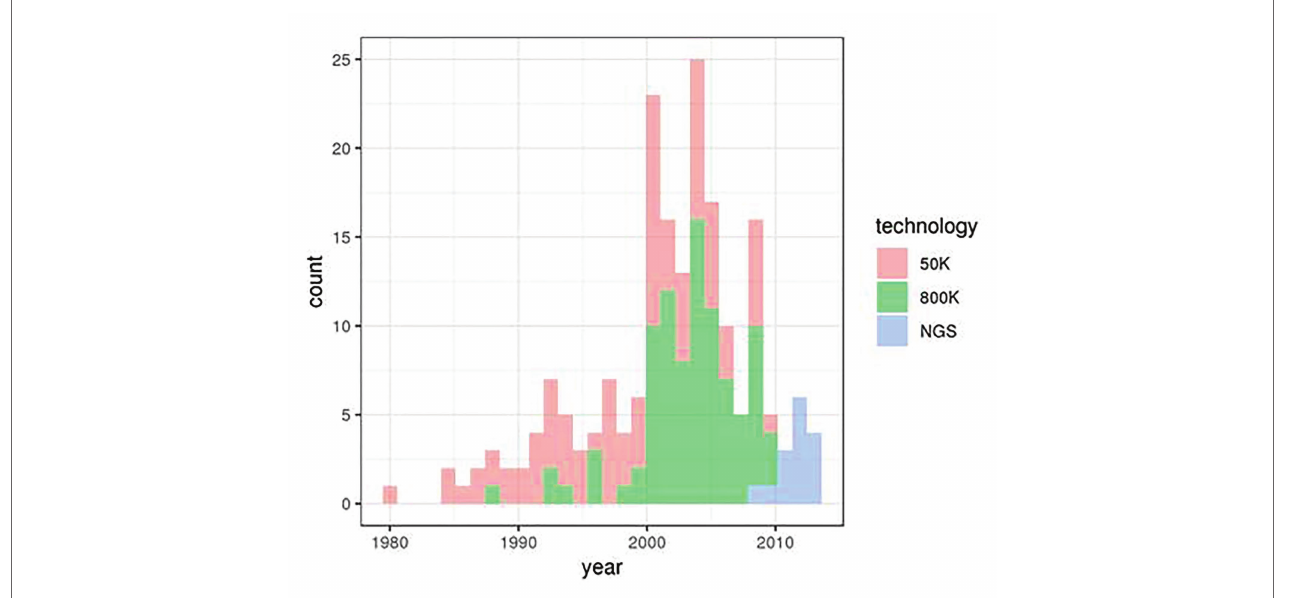
FIGURE 1 | Distribution of Asturiana de los Valles birth dates in the three original data